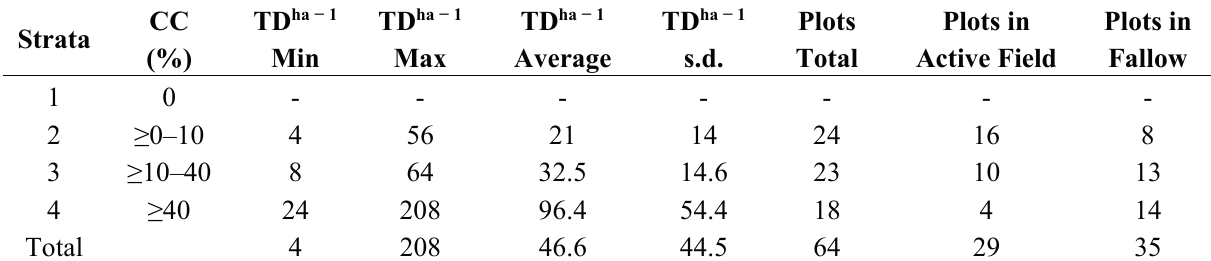
Table 2. Characteristics of the stratification used during field work, including tree canopy cover (CC), tree density (TD), standard deviation (s.d.) and distribution of field